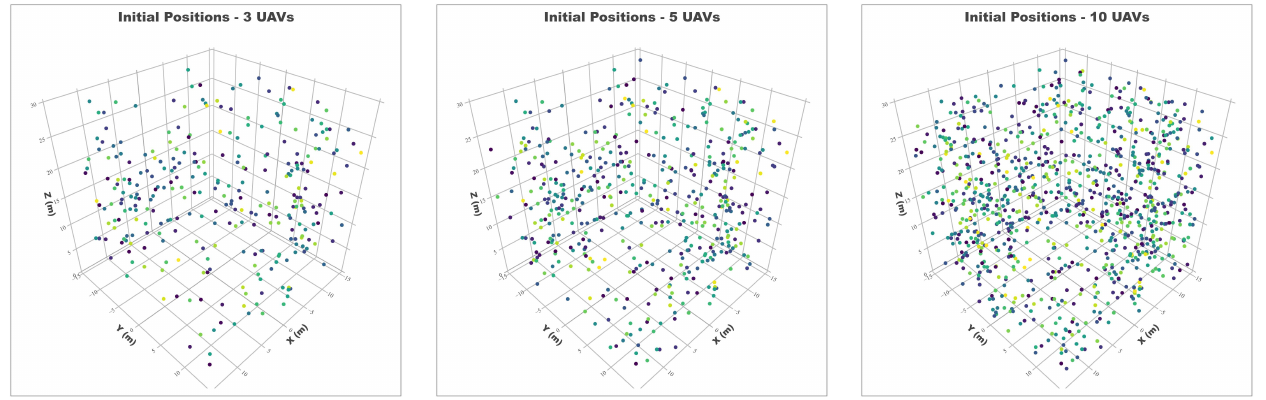
Figure 6. UAVs’ initial positions for the three case